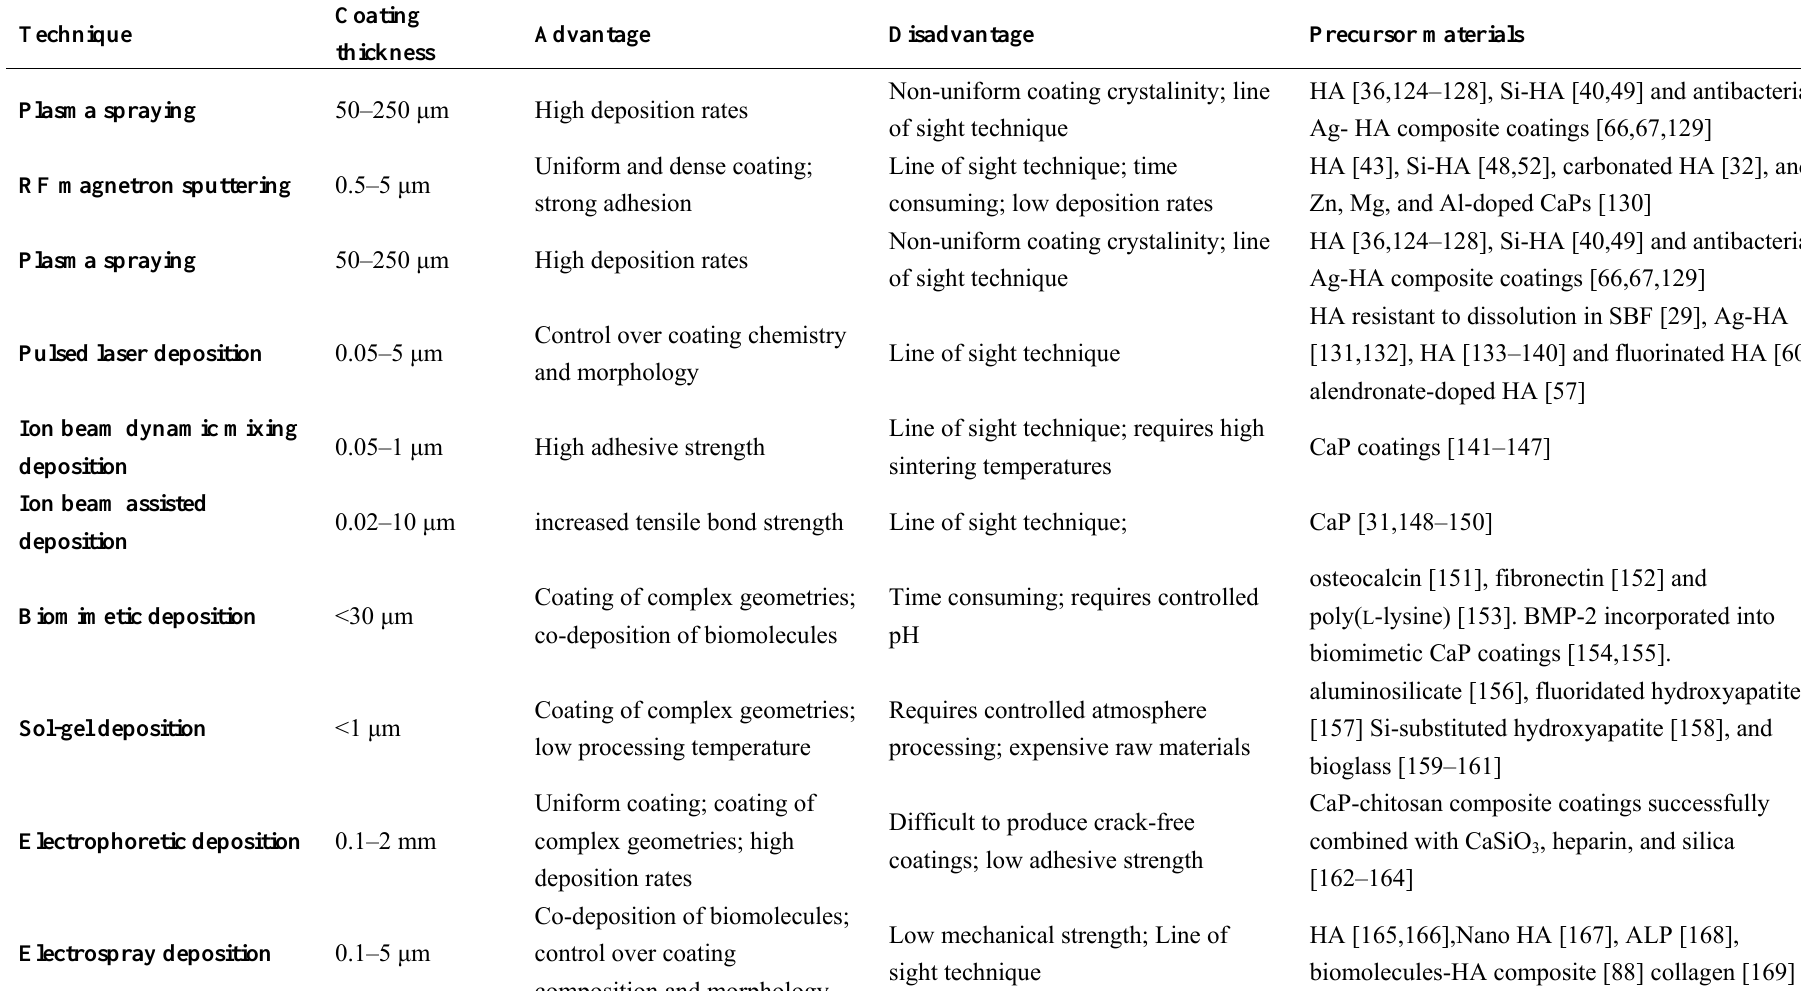
Table 2. Overview of characteristics of coating